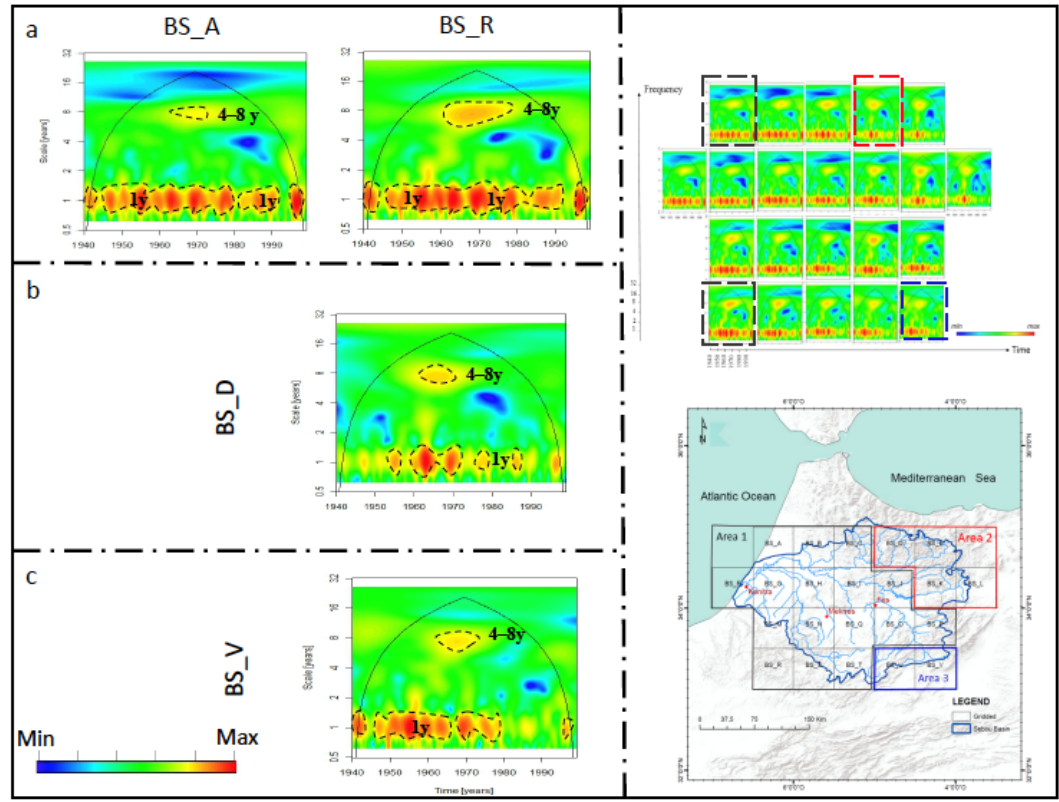
Figure 4. Variability of rainfall from SIEREM cells in Sebou basin is represented for ( a ) area 1, ( b ) area 2, and ( c ) area 3. Contrary to the other basins (Moulouya and Sebou), the Tensift basin is not subdi- vided (Figure 5), the variability of the annual mode being the same in the north and the south of the basin, except for some discontinuities also observed in the other basins. The 8–16-year frequency appeared in some cells in the south of the basin, and towards the end of the study series.